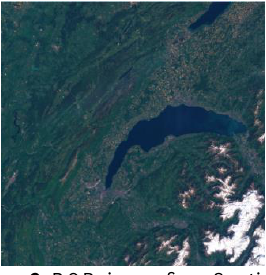
Figure 2 . RGB image from Sentinel-2